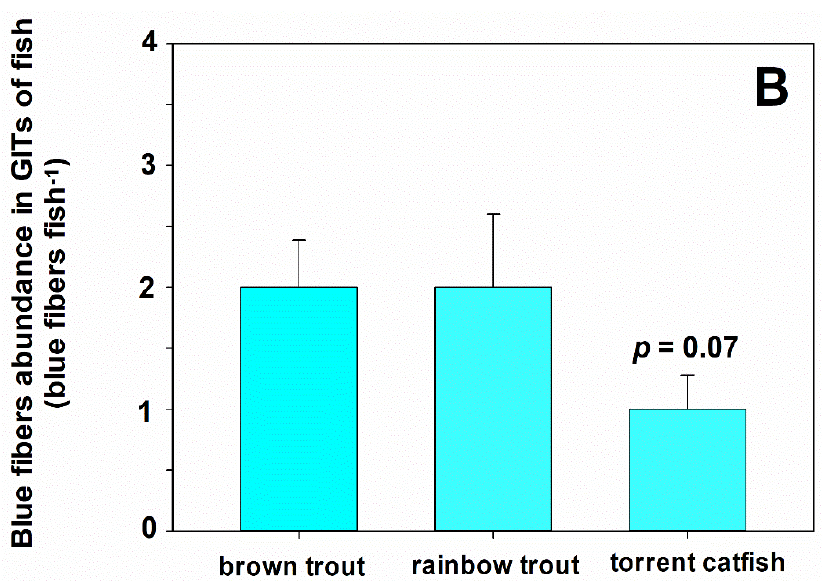
Figure 3. Total fiber abundance ( A ) and blue-fiber abundance ( B ) in fish GITs from Mendoza River in the Central Andes range. Bars represent medians and the whiskers standard errors. Different lower-case letters indicate significant differences in the fiber abundance among fish species (Kruskal–Wallis H test (KW), followed by a posteriori multiple comparisons of mean ranks for all groups). Table 3. Morphometric description of fish collected from Mendoza